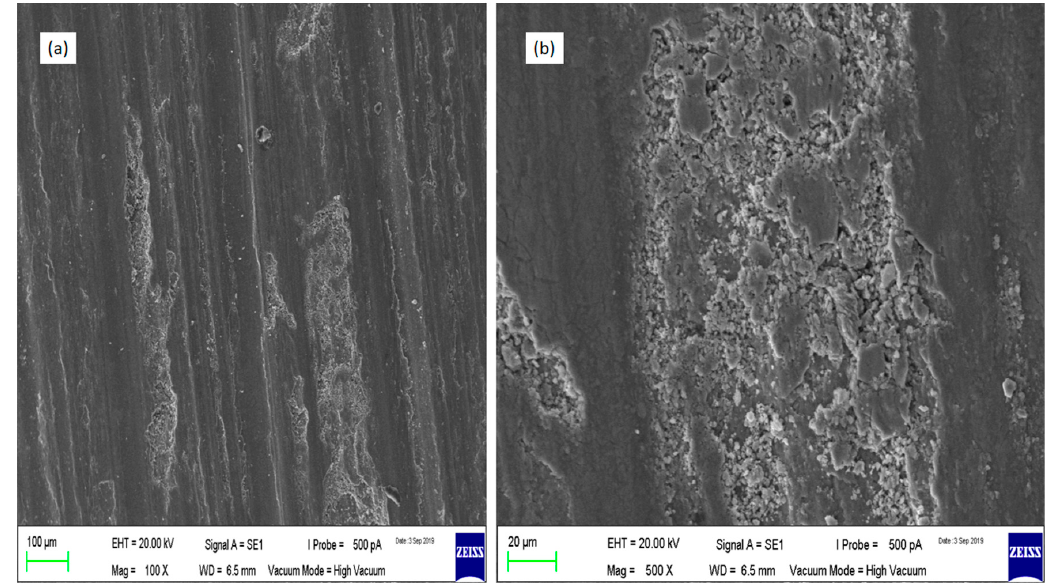
Figure 13. SEM micrographs of the wear tracks on Run 9 AA7075-SiC/fly ash surface composite samples ( a ) magnification 100× and ( b ) magnification 500×.